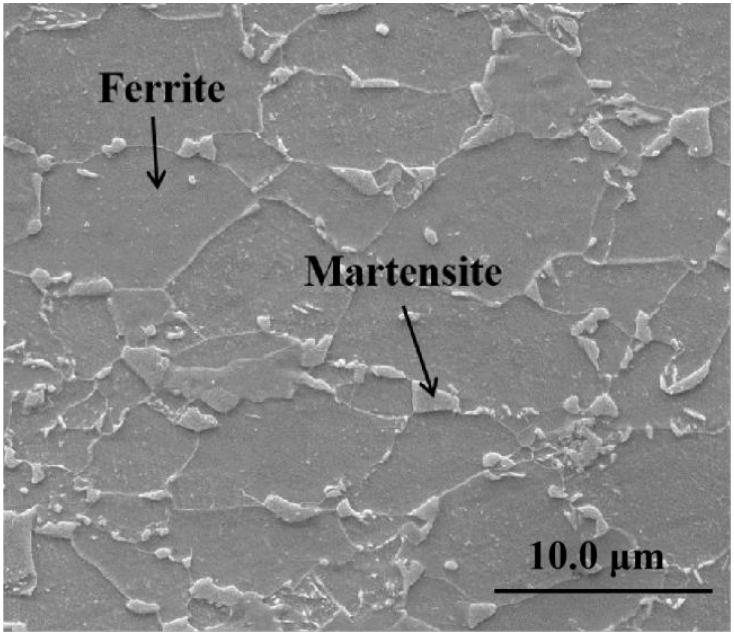
Table 2. The main mechanical properties of DP600 [17].